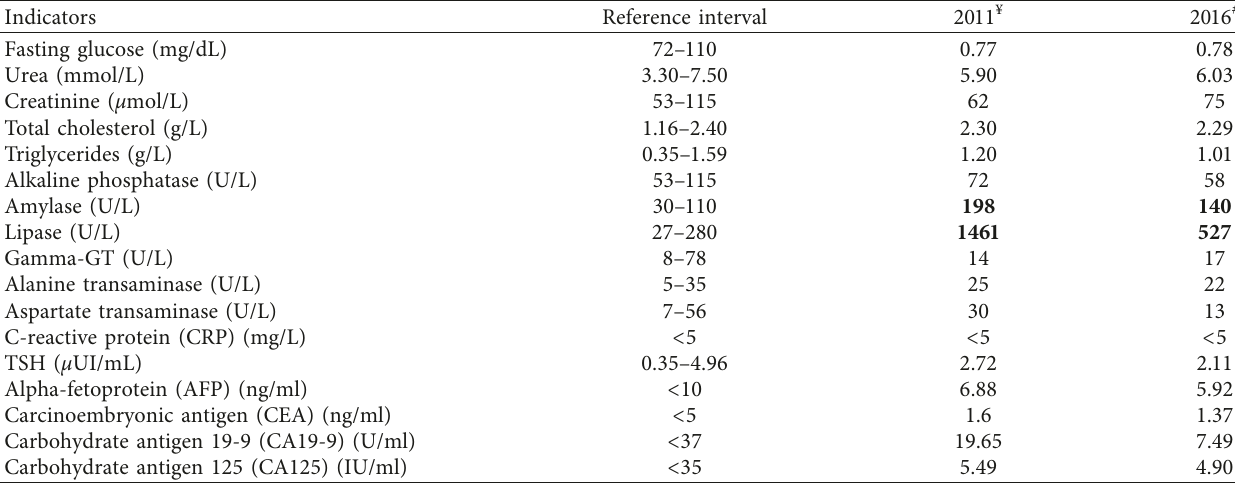
Table 1: Complementary exams.